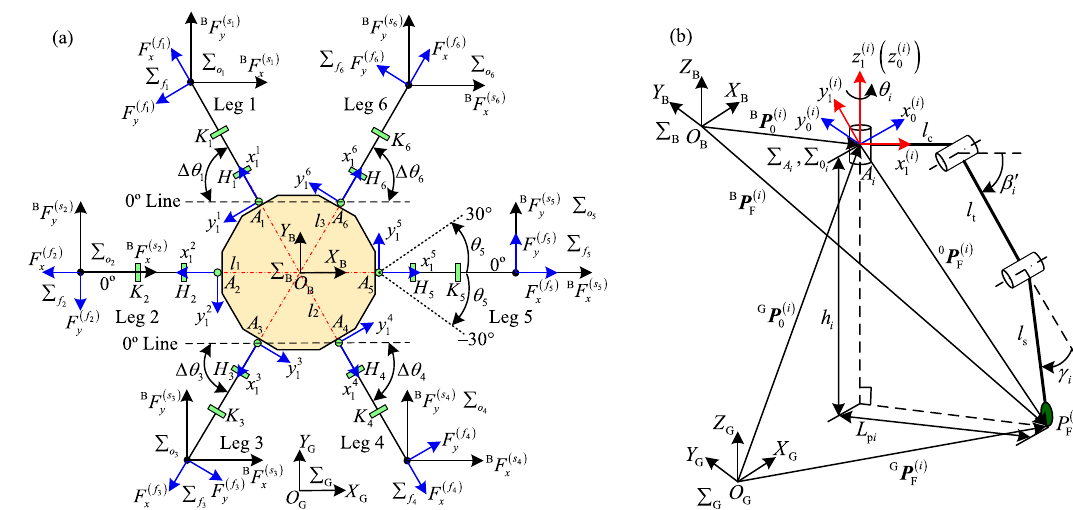
Figure 4 Top view of foot coordinate system and pose of single leg i [26]: a Foot coordinate system, b pose of single leg